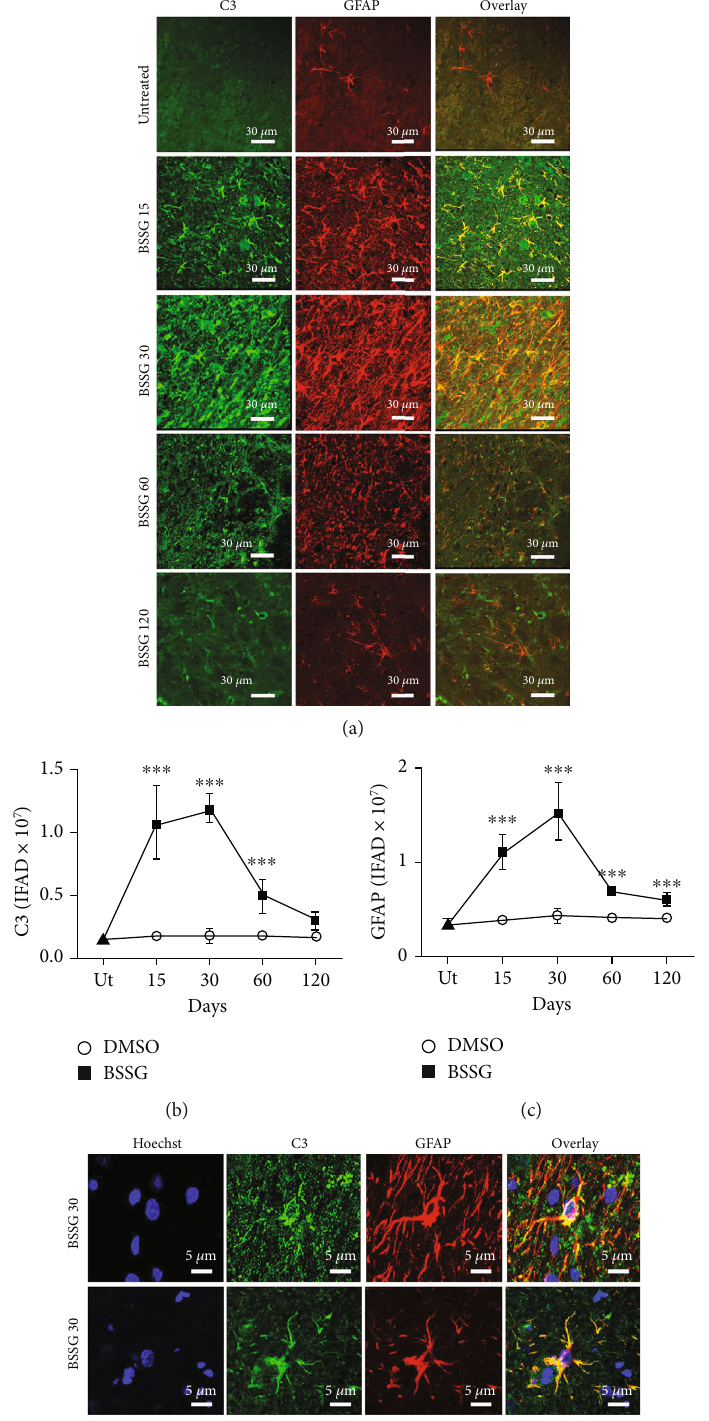
Figure 7: Colocalization of C3 and GFAP immunoreactivities after a BSSG injection in the SNpc. (a) Representative micrographs of the double in untreated (Ut) control rats and rats at di ff erent times (shown at the left side of micrographs) after BSSG injection. Immuno fl uorescence area density (IFAD) for C3 (b) and GFAP (c) was determined using the ImageJ software v.1.46r (National Institutes of Health, Bethesda, MD). The C3 and GFAP values for the mock rats correspond to the quanti fi cation in Supplementary Figure 6. (d) Details of cells coexpressing C3 and GFAP on day 30 after a BSSG injection in the SNpc. The values are the mean ± SD from four anatomical levels. n = 3 independent rats in each time of each experimental condition. Two-way ANOVA and post hoc Bonferroni tests were applied for statistical analysis. ( ∗∗∗ ) indicates a P < 0 : 001 compared with the DMSO mock and Ut groups of the respective